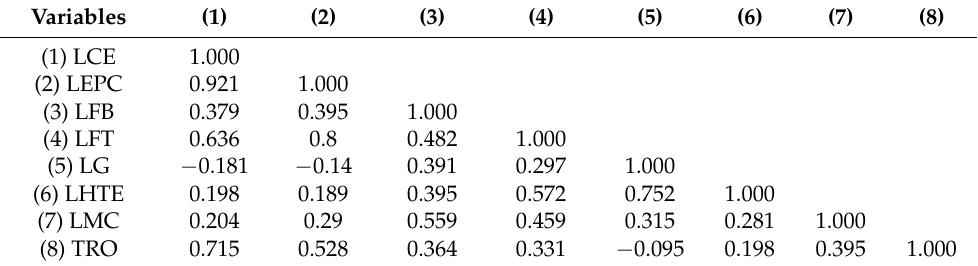
Table 2. Matrix of correlations.